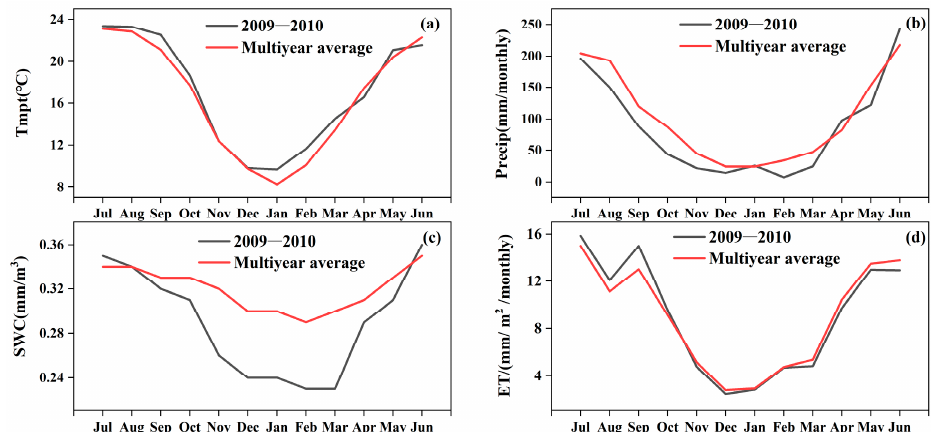
Figure 3 . Regional mean interannual variation in ( a ) temperature ( b ) precipitation ( c ) soil moisture and ( d ) ET in three provinces from July 2009 to June 2010. (The red line shows the monthly average from July 2009 to June 2010, and the black line indicates the multiyear monthly average from 2000 to 2019 (ET is from 2000 to